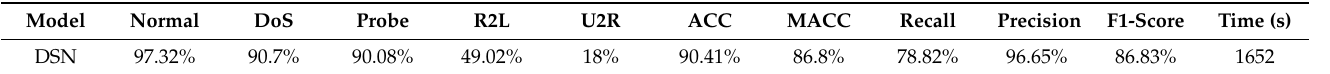
Table 7. Detection performance of the proposed DSN.